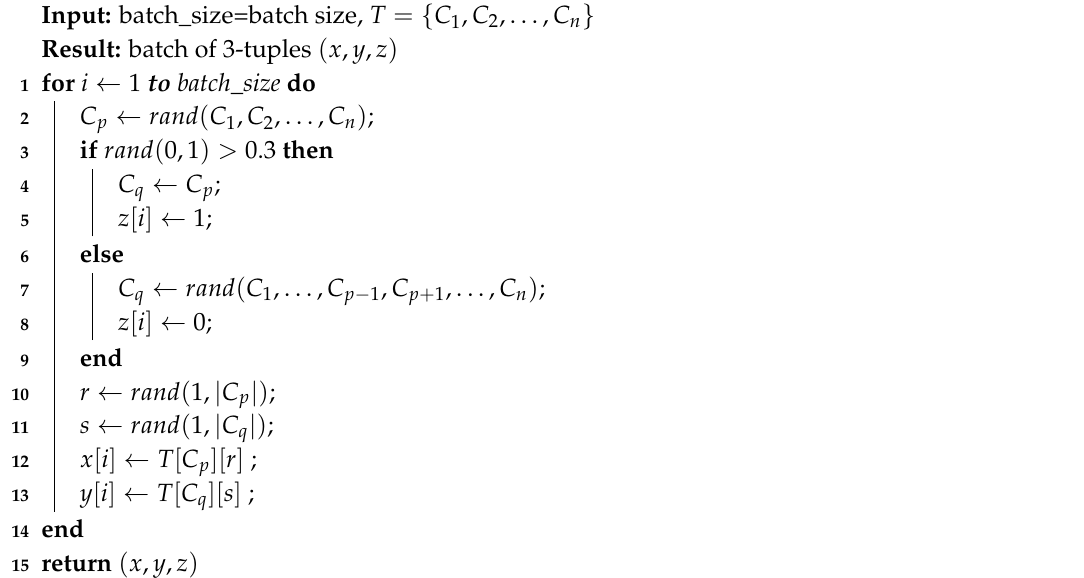
Algorithm 1: Building the batches of 3-tuples for CSN training.